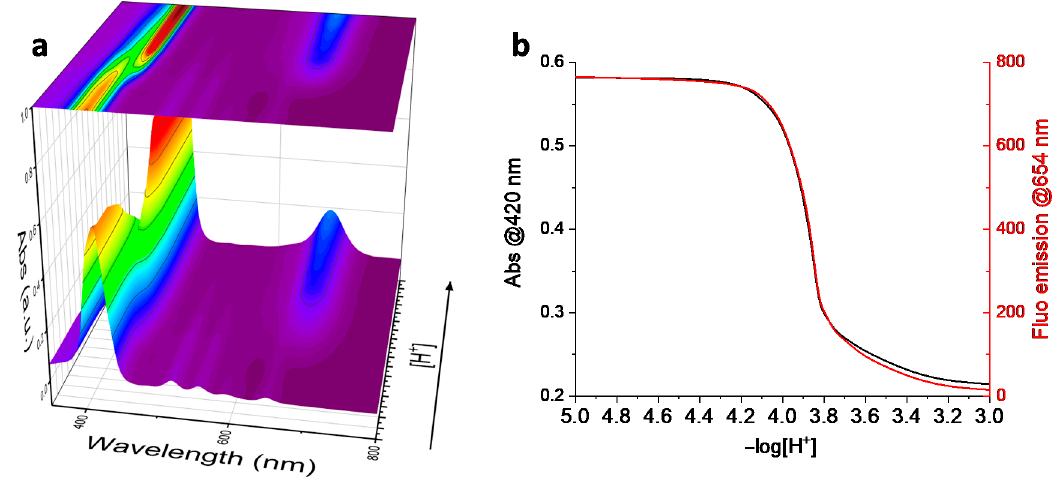
Figure 9. UV-Vis HCl-diluted solution titration of P(PEG750) 4 water solution (5 μ M): ( a ) 3D representation of the UV-Vis spectra acquired during the H + titration; ( b ) titration curve obtained monitoring the UV-Vis absorbance at 420 mn (black line) and the fluorescence emission intensity at 654 nm (red line, λ exc = 420 nm).